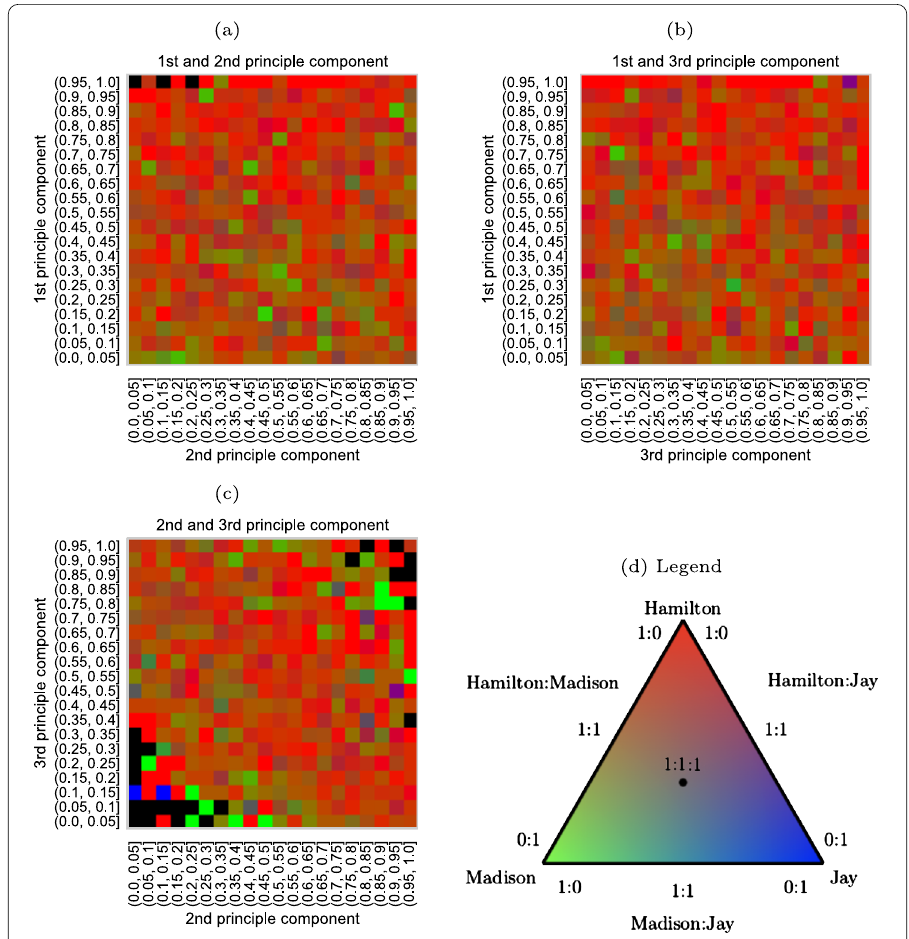
Figure 5 Discrimination maps for the first three principle components derived from 251 language time series features of the Federalist Papers with known authors. The features have been identified as being statistically significant for discriminating the authors. The principle components were calculated from all 4987 sentences. The legend in panel ( d ) shows the colour coding of the pixels. Black pixels indicate bins without any